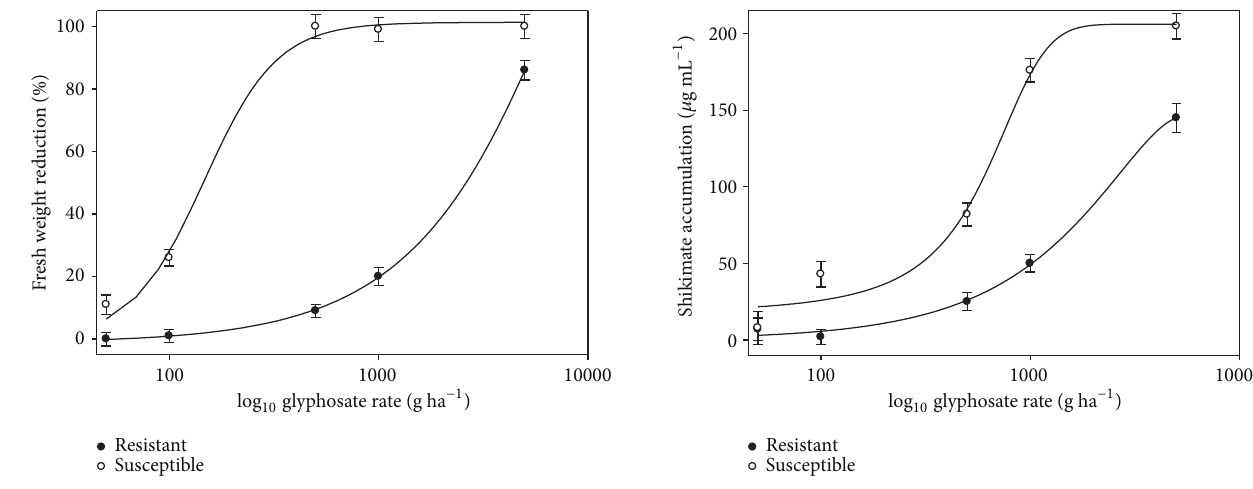
Figure 1: Percent reduction in Palmer amaranth fresh weight of glyphosate-resistant and glyphosate-susceptible biotypes 21 days after glyphosate application. Data are pooled over two experiments. Regression expressions are resistant biotype, 𝑌 = 0.000001𝑥 2 + 0.02𝑥−1.3 , 𝑟 2 = 0.99 ; susceptible biotype, 𝑌 = 101/(1+(𝑥/146) −2.5 ) , 𝑟 2 = 0.99 .